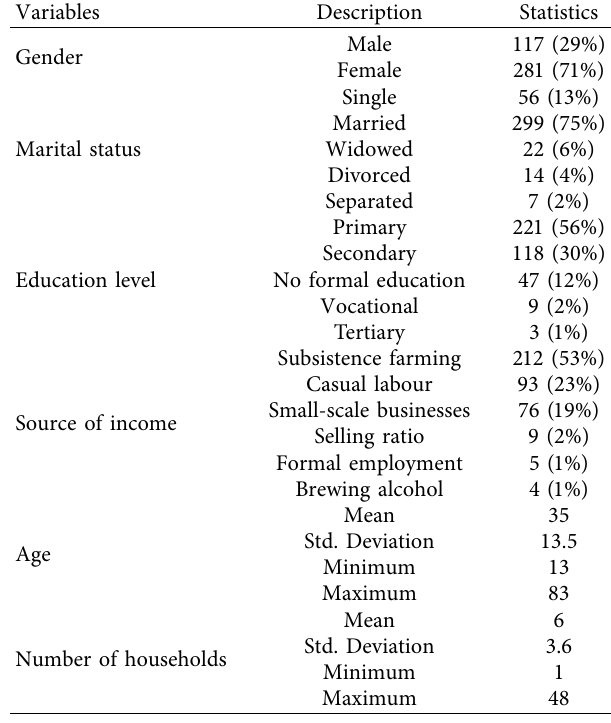
Table 1: Sociodemographic characteristics of refugees sampled ( N �